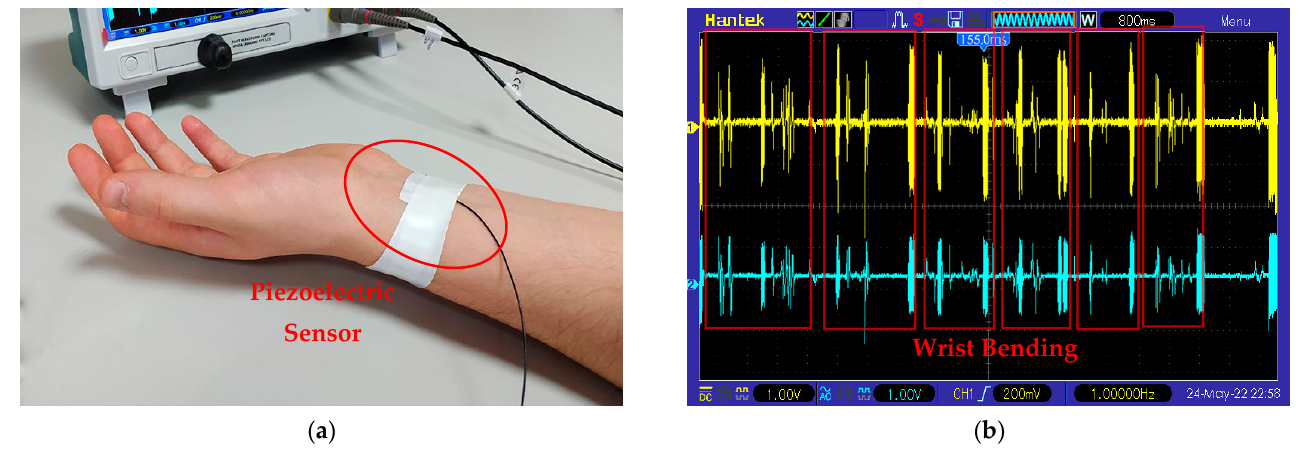
Figure 31. Application of the sensor on the wrist ( a ) and corresponding output signal V out (yellow trace) and the filtered output signal V out, filtered (cyan trace) related to wrist bending ( b ).